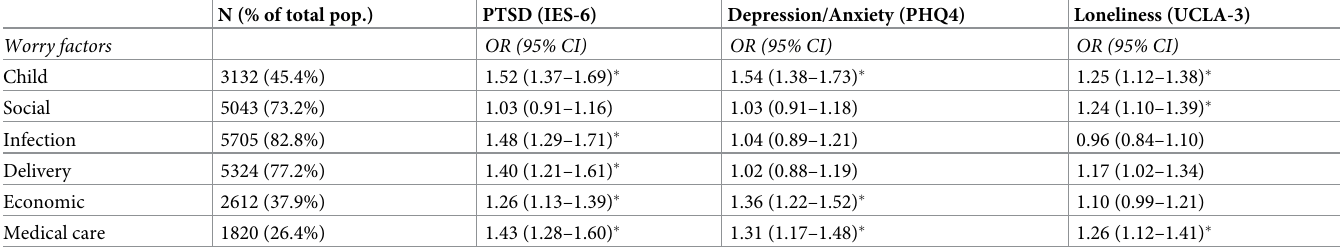
Table 3. Results of multivariable logistic regression models for elevated symptoms of PTSD, depression/anxiety, and loneliness in relation to the six COVID-19 worry factors a . N (% of total